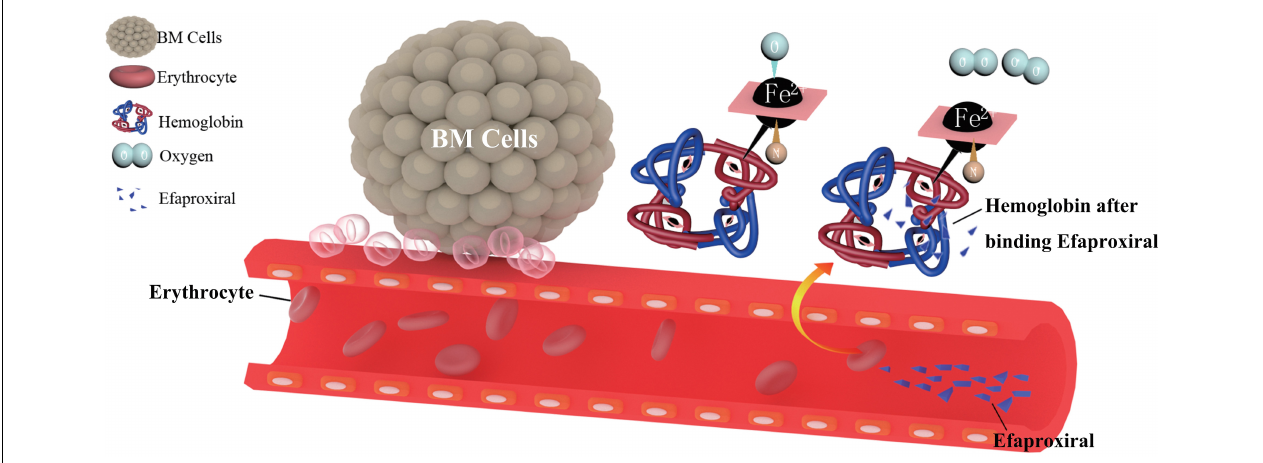
FIGURE 1 | The pharmacological mechanism of efaproxiral. Efaproxiral is an allosteric modifier of hemoglobin. It decreases oxygen affinity by stabilizing the central water cavity of the hemoglobin tetramer (Wireko et al., 1991). With the conformational structure changed, there will be an increase in whole-blood P50 (partial pressure of oxygen which results in 50% hemoglobin saturation) and an increase in the PO 2 (partial pressure of oxygen) in the tissue, expected to decrease the hypoxic fraction of brain metastasis and increase its sensitivity to RT (Suh, 2004).